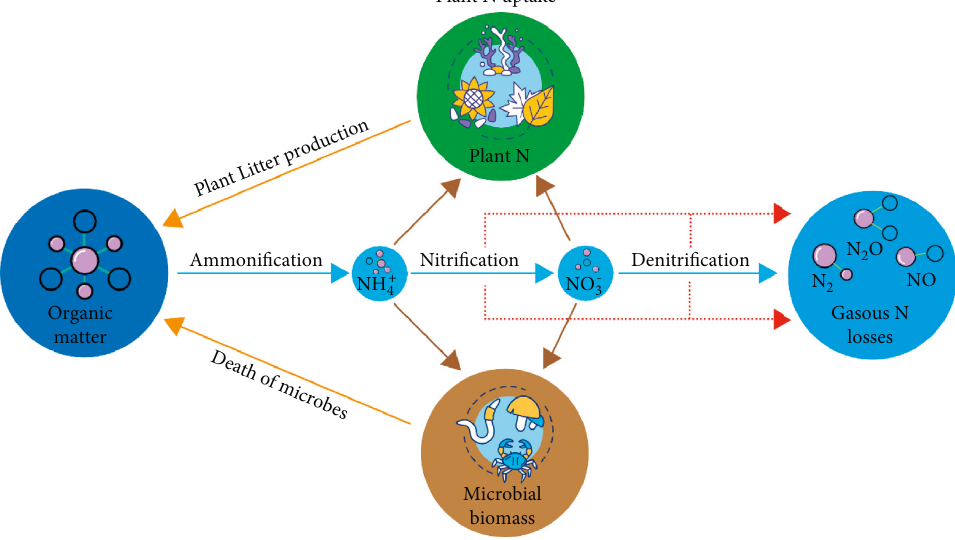
Figure 1: Nitrogen transport